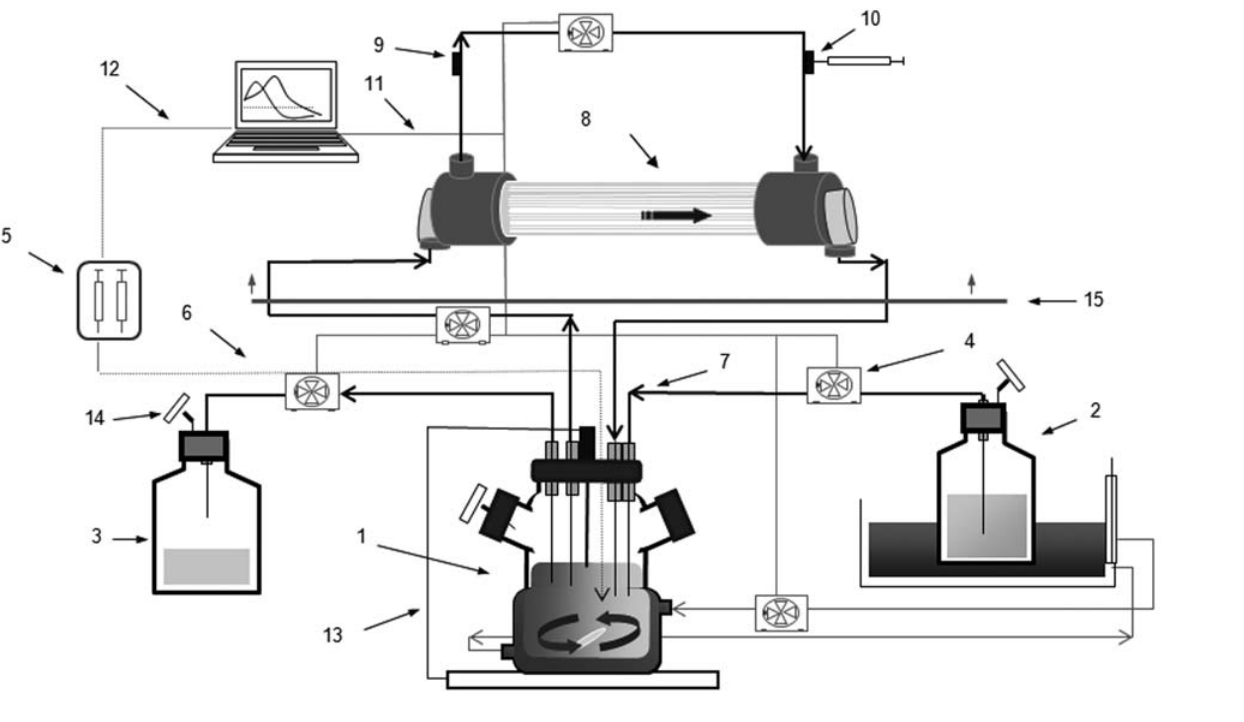
Figure 1. Pharmacodynamic computerized device. Diagram of the in vitro two-compartment computerized device used in the study.